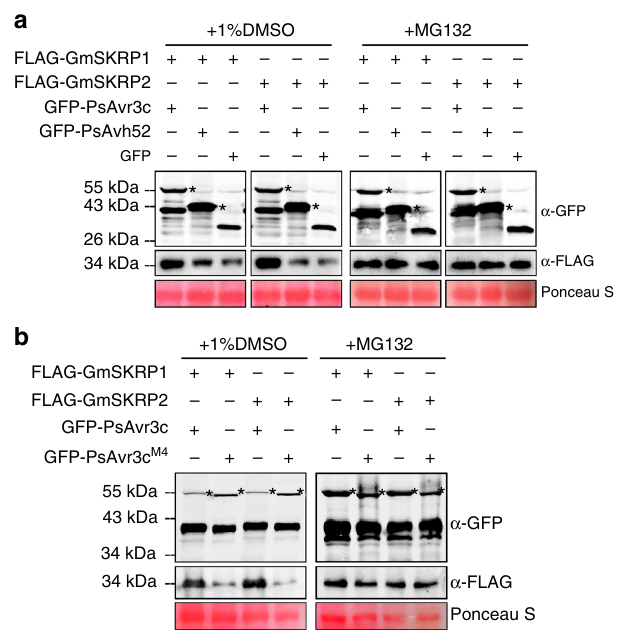
Fig. 3 PsAvr3c stabilizes GmSKRP1/2 in planta. a PsAvr3c stabilizes GmSKRP1/2 proteins in planta. The FLAG-GmSKRP1/2 were co-expressed with GFP-PsAvr3c, GFP-PsAvh52, or GFP, and then in fi ltrated with 1% DMSO (control) or 50 μ M proteasome inhibitor MG132 at 36 hpi. Total proteins were extracted at 48 hpi. PsAvh52 is a nucleus localized effector but does not bind to GmSKRP1/2. Immuno-blotting showed an increased signal from FLAG-GmSKRP1/2 in the presence of GFP-PsAvr3c but not with control protein GFP-PsAvh52 or GFP (left lanes). The degradation of FLAG-GmSKRP1/2 is inhibited by MG132 (right lanes). The position of expected protein bands are indicated by asterisks and protein loading was determined by Ponceau stain. b PsAvr3c M4 does not stabilize GmSKRP1/2 protein in planta. PsAvr3c M4 is a PsAvr3c mutant that fails to bind GmSKRP1/2. Western blotting showing an increased signal from FLAG- GmSKRP1/2 in the presence of GFP-PsAvr3c but not with GFP-PsAvr3c M4 (left lanes). The degradation of FLAG-GmSKRP1/2 is inhibited by MG132 (right lanes). The position of expected protein bands are indicated by asterisks and protein loading was determined by Ponceau